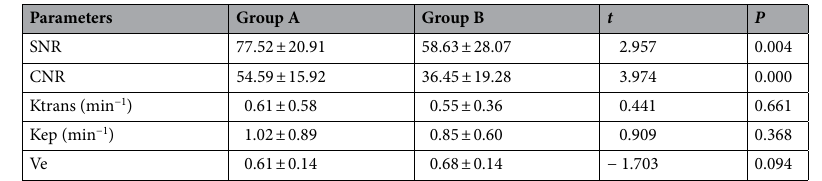
Table 2. Comparisons of objective image quality and DCE-MRI parameters between the groups. SNR signal to noise ratio, CNR contrast noise ratio, Ktrans volume transport constant, Kep reflux rate constant, Ve vascular extracellular volume fraction.